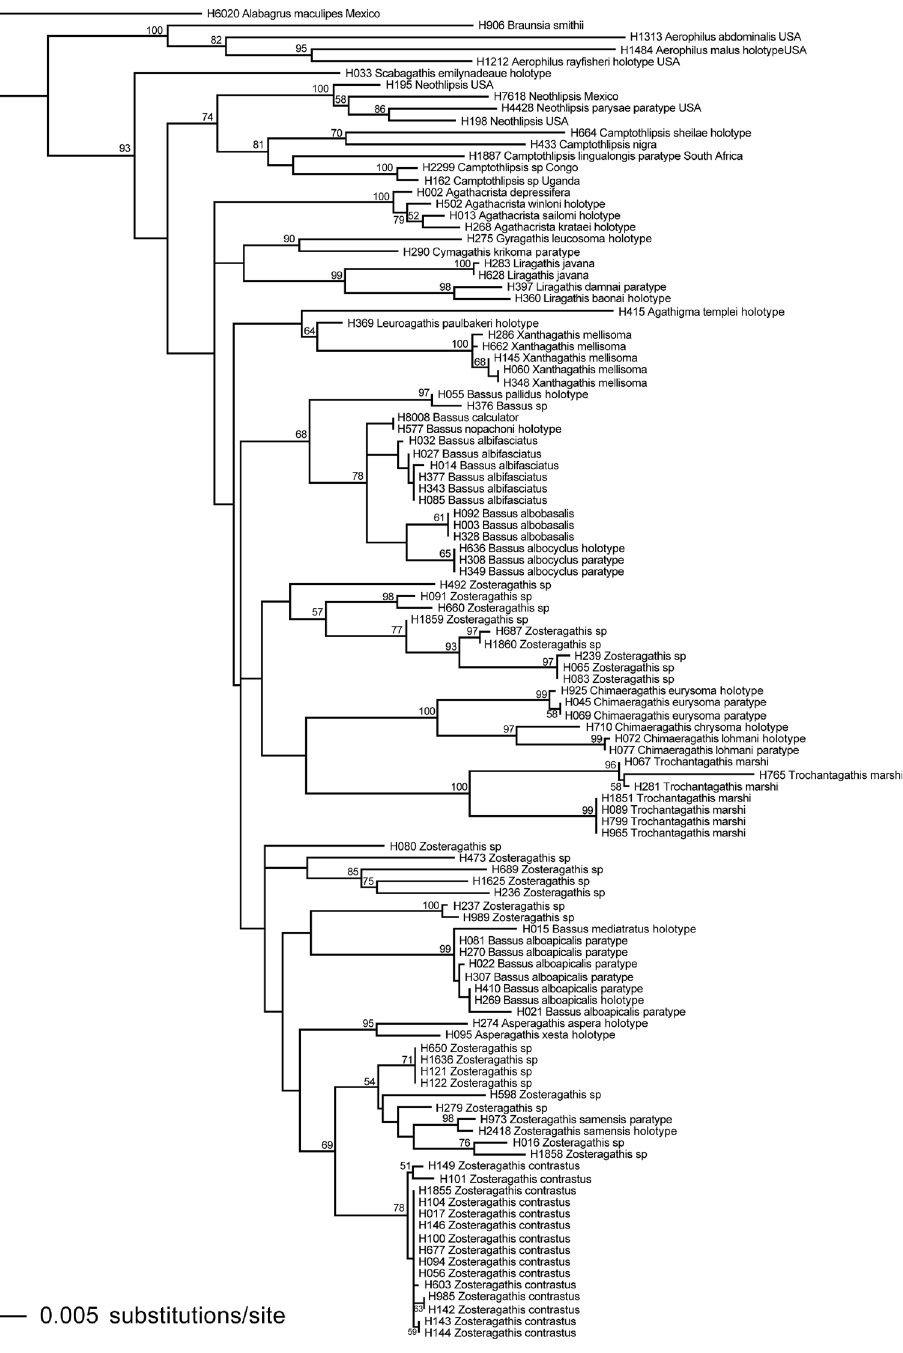
Figure 1. Tree of highest log-likelihood from 20 ML search reps of the combined COI+28S data set with bootstrap values ≥50% plotted at the